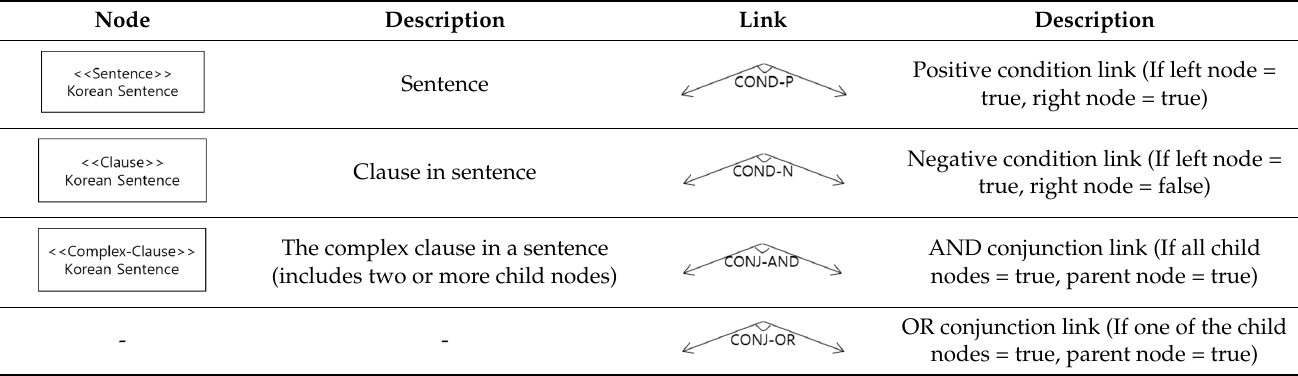
Table 8. C3Tree Notation.